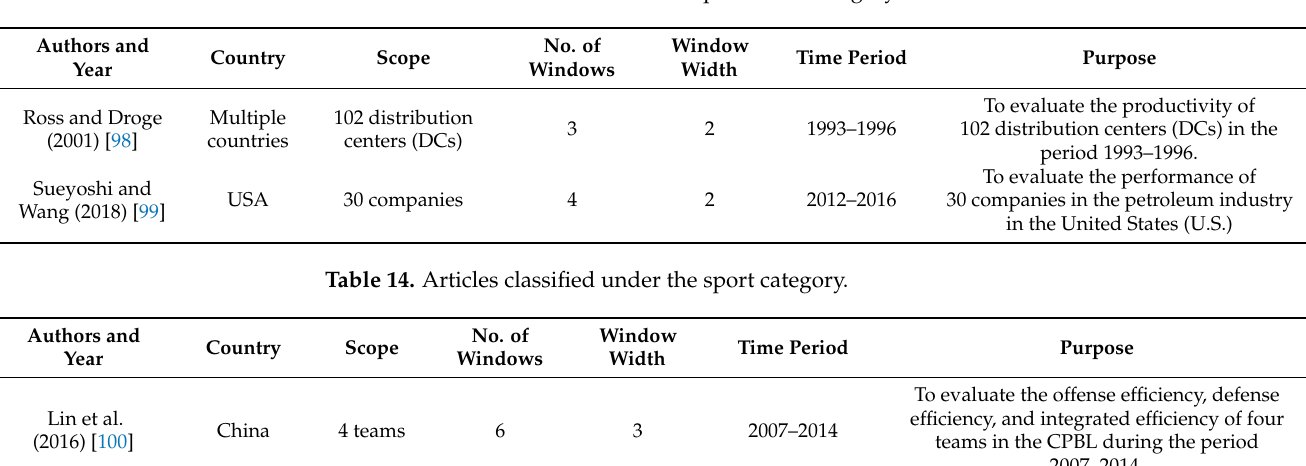
Table 13. Articles classified under the petroleum category.